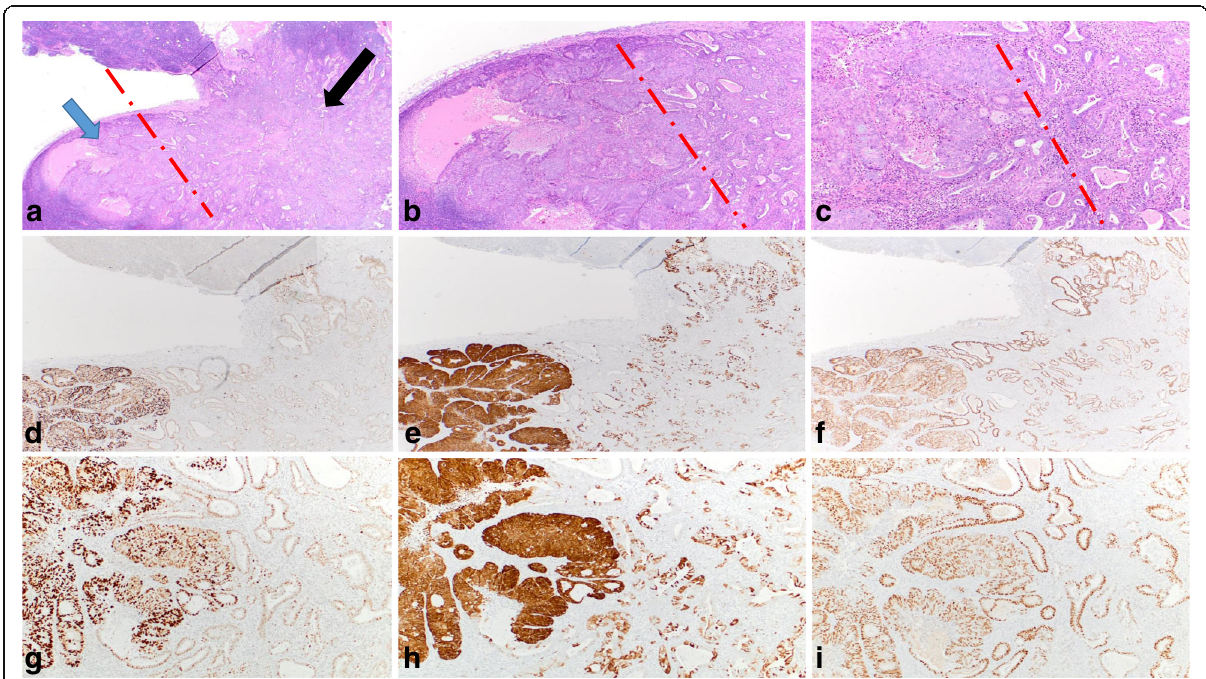
Fig. 2 Morphologic and immunophenotypic features of tumor in one lymph node. a - c The 2 components of the tumor (ie areas that were ultimately classified as p53 wild-type (black arrow) and p53-aberrant (gray arrow) were apposed but not intermixed. An red line ap- proximately separates the 2 areas. [H and E, original magnification: 2 x (1A); 4× (1B); 10× (1C)]. d , g p53 immunohistochemistry, showing different patterns of expression in both areas of the tumor [original magnifications: 2 x (1D); 10× (1G)]. e , h p16 immunohistochemistry, showing different patterns of expression in both areas of the tumor [original magnifications: 2 x (1E); 10× (1H)]. f , i Progesterone receptor immunohistochemistry showing similar patterns of expression in both components [original magnifications: 2 x (1E); 10×